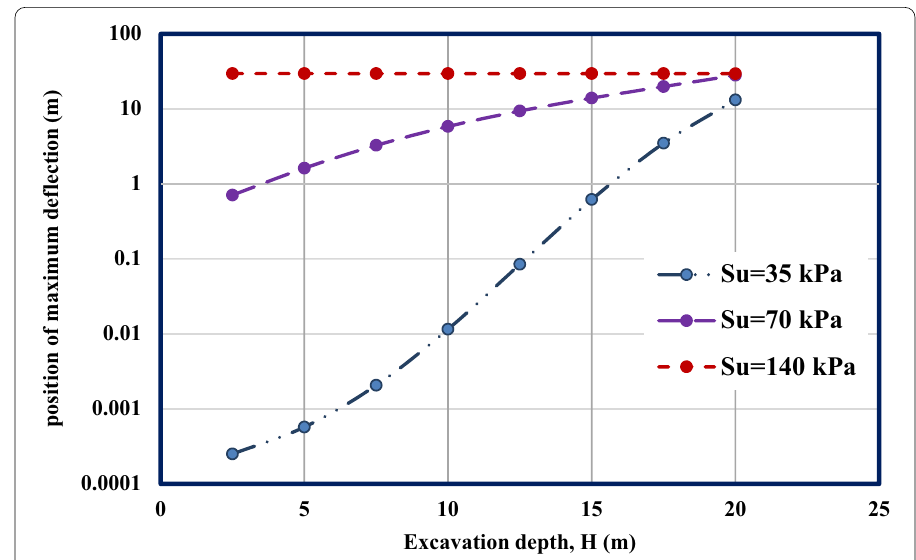
Fig. 12 Position of maximum wall deflections predicted by the ANN versus variation excavation depth, for L/B 1, Ko 0.53, hs 2.5 m, EI wall/EI brace = = =